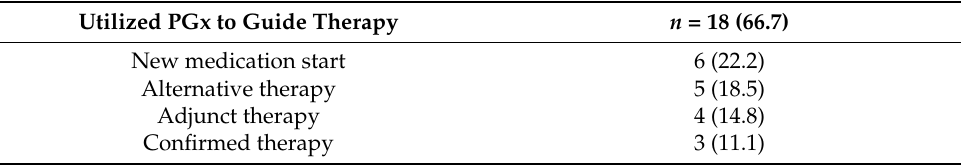
Table 7. PGx informing the therapy